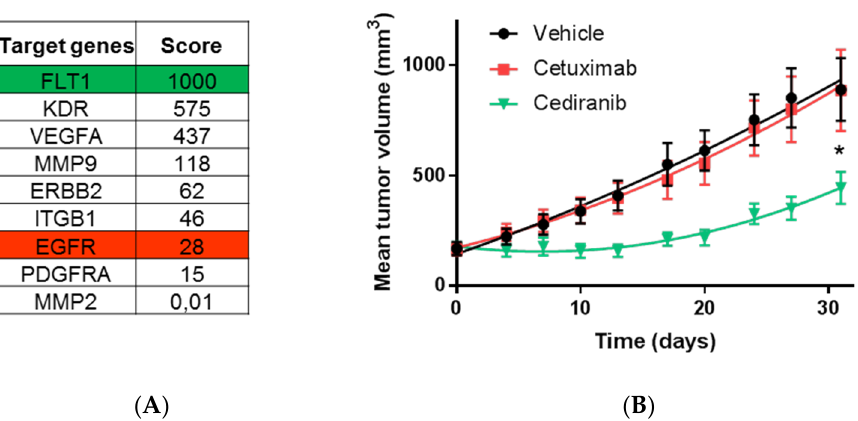
Figure 8. The highest score of the normalized signature is predictive of drug efficacy. ( A ) Ranking of target genes obtained after normalization of the expression data in PDX model CR IC 028M-P3. ( B ) Evaluation of the predictive value of the scores in the PDX model CR IC 028M-P3 known to be refractory to anti-EGFR treatment (Cetuximab). Mean tumor volumes measured during the time of treatment with Cetuximab (red line) predicted to be inefficient, Cediranib (green line) predicted to be the most efficient drug among the selected target of the signature or vehicle (black line) used as a positive control of tumor growth. Student t test analysis (ns: not significant; * p < 0.05).